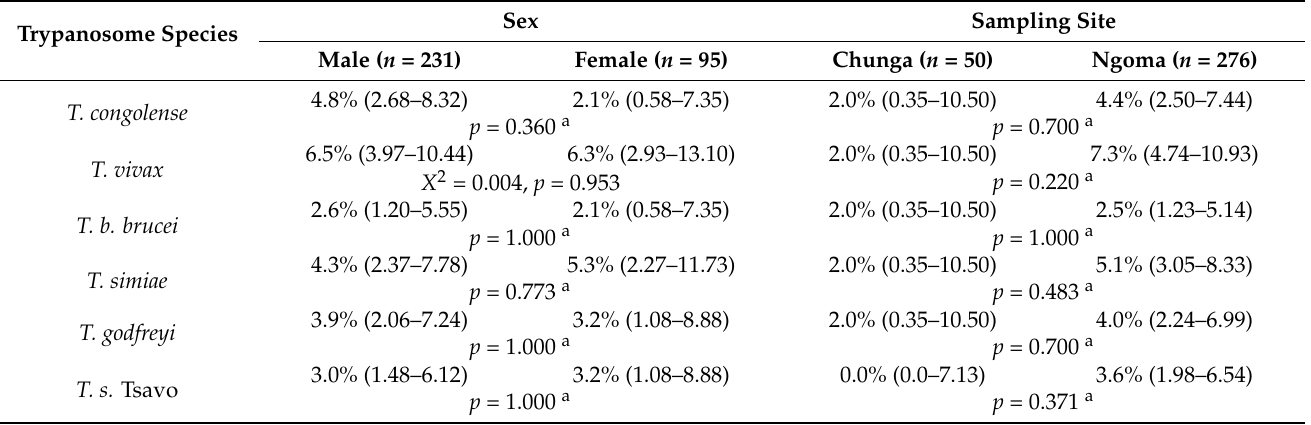
Table 4. Prevalence of trypanosome species according sex and sampling site of tsetse